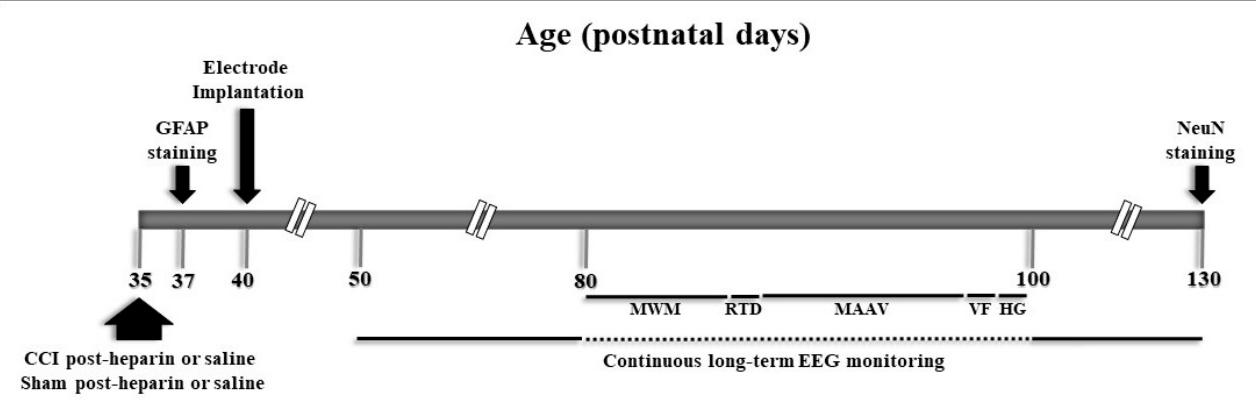
Figure 2. Experimental design. Postnatal day 35 (P35) rats were subjected to closed-head controlled cortical impact (CCI) 20 min post-heparin or post-saline injections. Controls were sham treated post-heparin or post-saline injections. Following epidural electrode implantation surgery at P40, rats underwent long-term continuous EEG monitoring from P50 to P80 and from P100 to P130. The EEG recording was interrupted between P80 and P100 to conduct behavioral testing. The behavioral testing panel consisted of the Morris water maze (MWM) at P80-85, the rotarod (RTD) motor test at P86, the modified active avoidance (MAAV) at P88-94, the Von Frey (VF), and the Hargreaves (HG) sensory tests at P96 and P97, respectively. At P130, rats were sacrificed to assess for neuronal loss with neuronal nuclei (NeuN) staining. A subgroup of rats was sacrificed 48 h post-CCI for the assessment of reactive astrogliosis with glial fibrillary acidic protein (GFAP) staining.